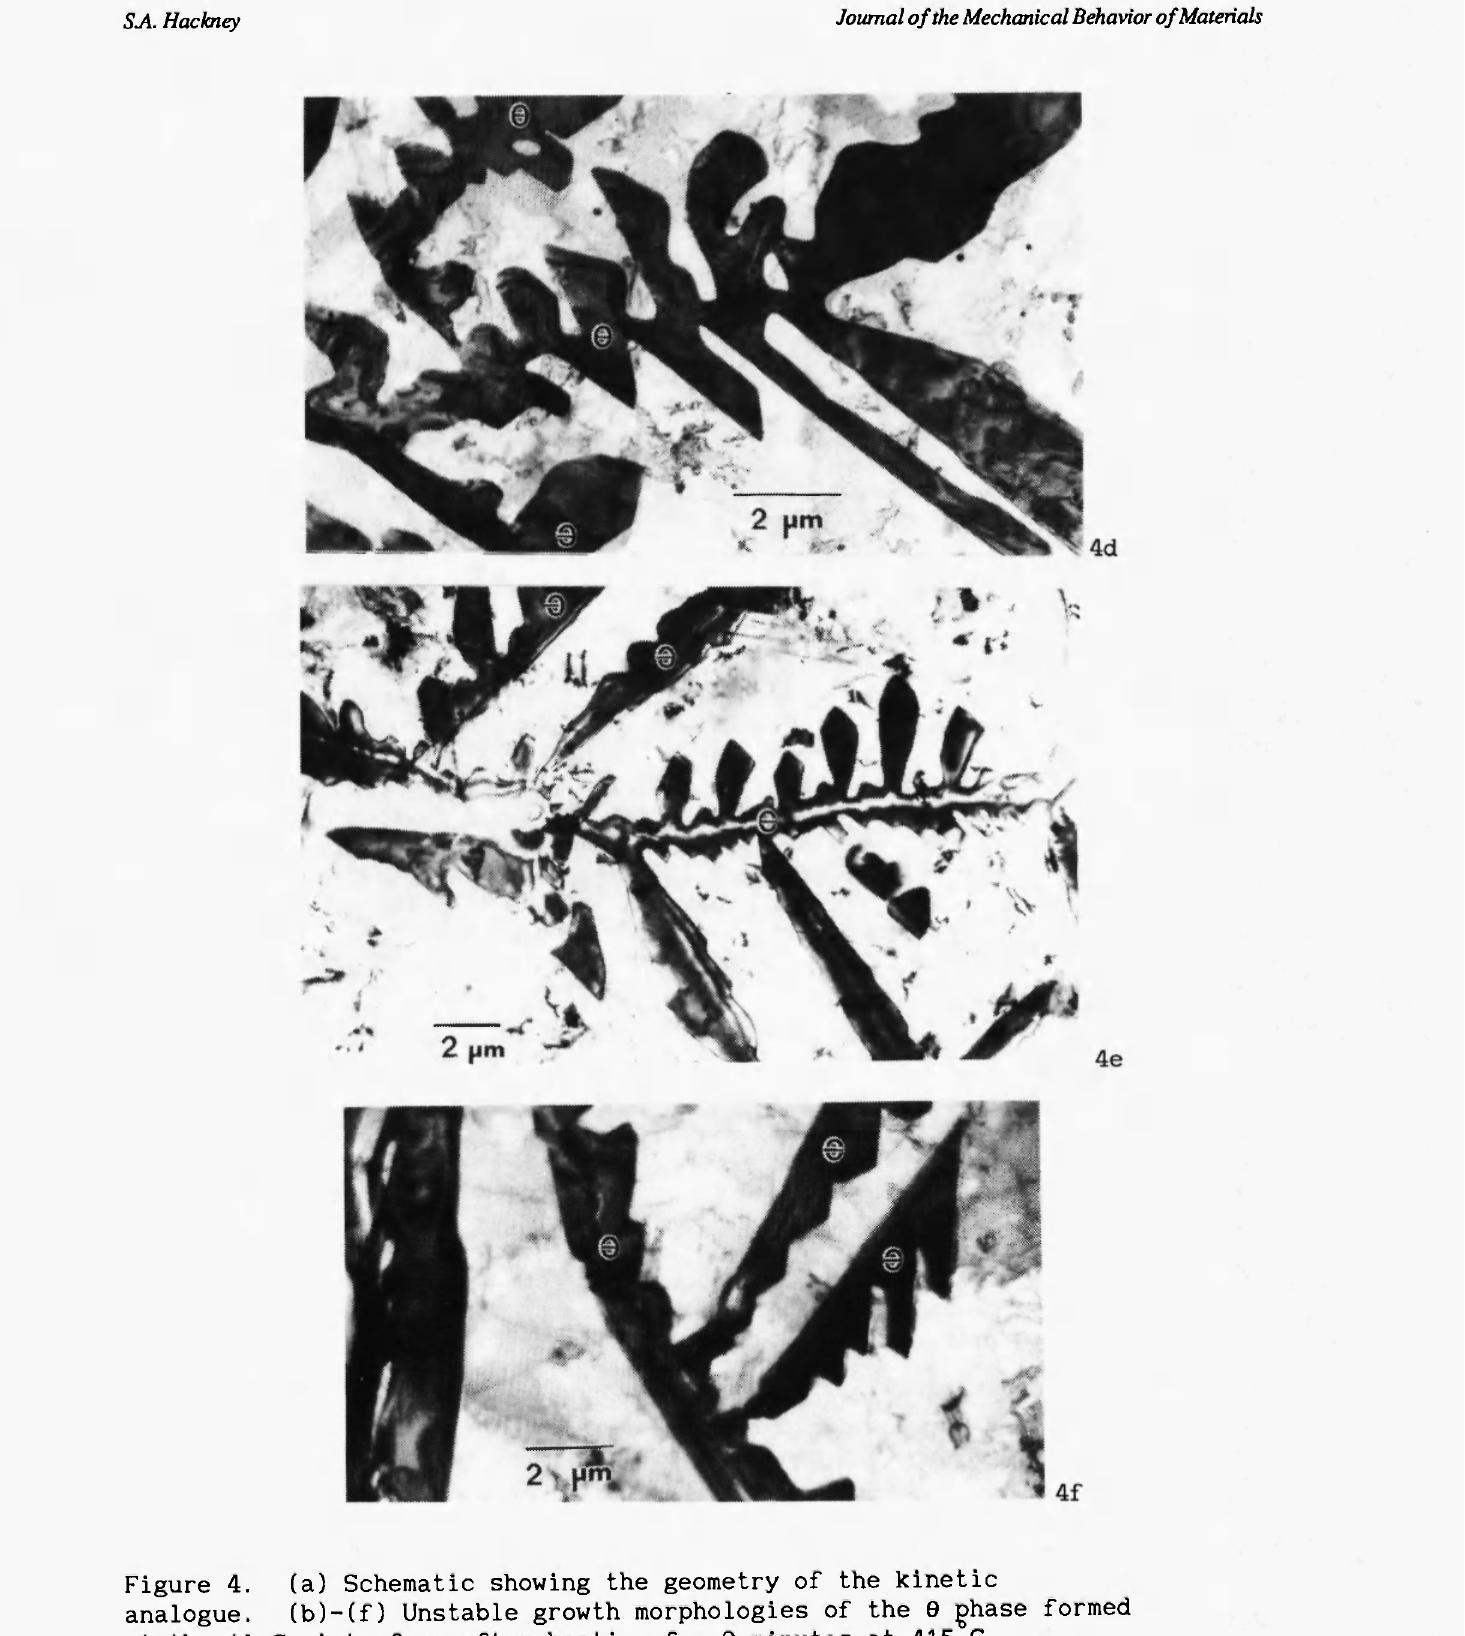
Figure 4. (a) Schematic showing the geometry of the kinetic analogue. (b)-(f) Unstable growth morphologies of the θ ghase formed at the Al-Cu interface after heating for 2 minutes at 415